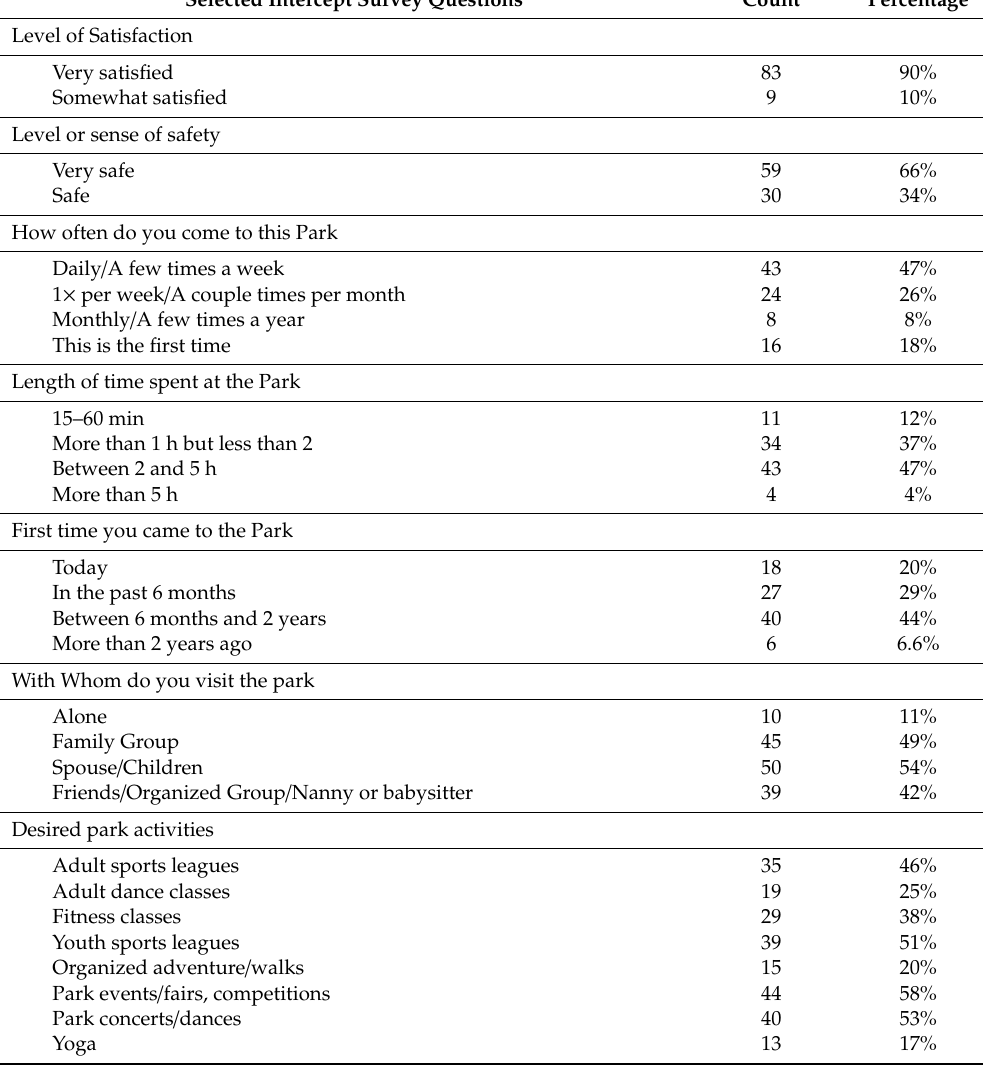
Table 3. Park user opinions based on intercept interview